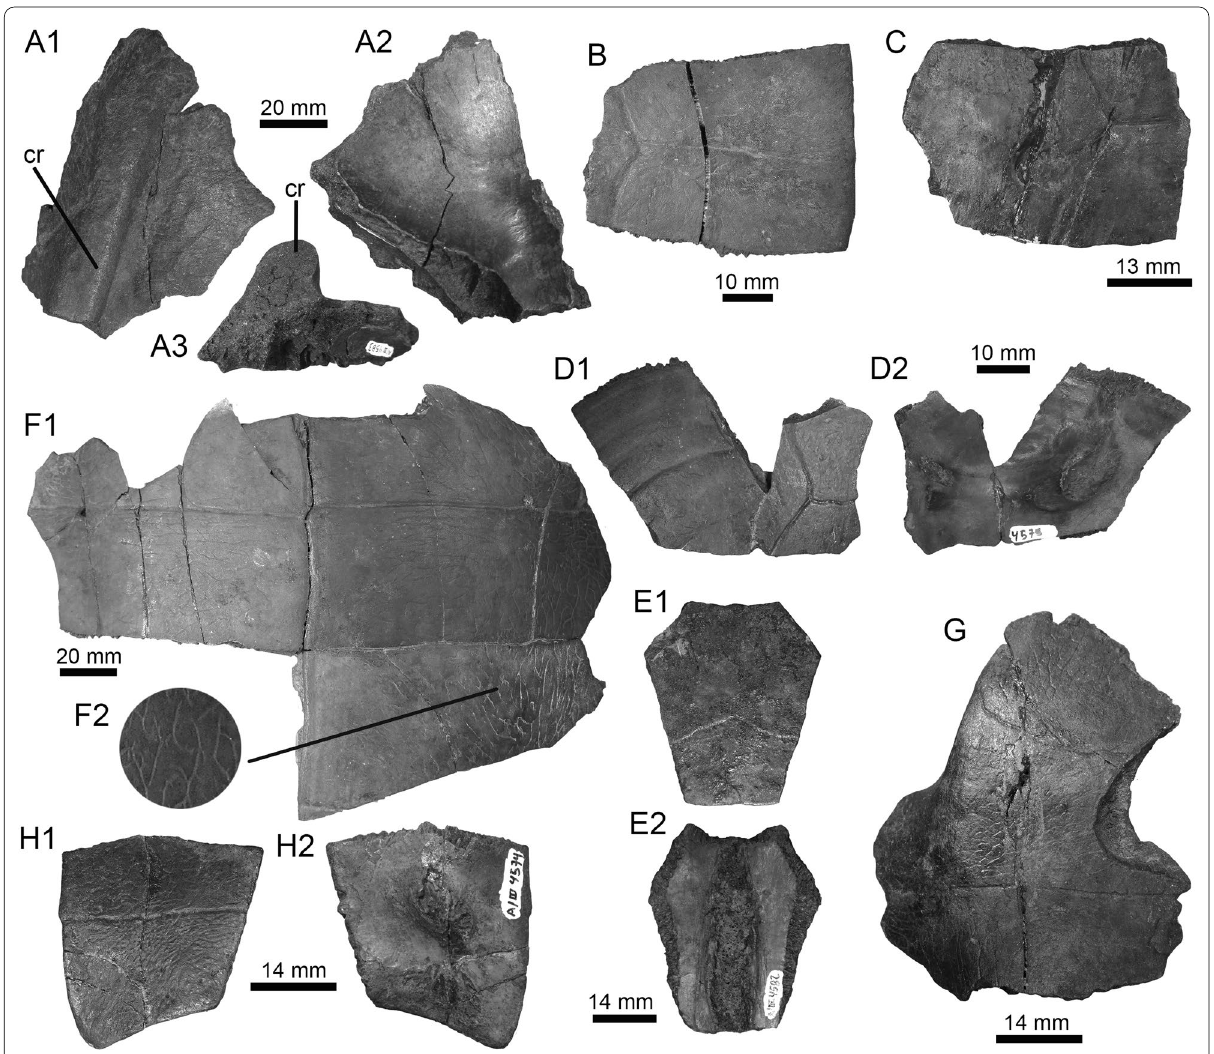
Fig. 8 Testudines from the Iquitos assemblage. A1 – A3 left costal 1 of † Chelus colombianus . B – H2 Indeterminate podocnemidids. B Peripheral bone (PIMUZ A/III 4574A). C – D2 Medial portion of a costal bone potentially costal 2 ( C : PIMUZ A/III 4576A) and left costal 1 ( D 1– D2 : PIMUZ A/III 4576B). E1 – E2 Neural bone, potentially neural 3 (PIMUZ A/III 4582). F 1– F2 Partially preserved plastron, including most of both hyoplastra and the left hypoplastron (PIMUZ A/III 4571), and close‑up ( F2 ) of its bone surface exhibiting dichotomy sulci. G Partially preserved right hyoplastron (PIMUZ A/III 4576C). H 1– H2 Complete right xiphiplastron (PIMUZ A/III 4574B). Abbreviations: cr (costal ridge). Views: external surface ( A1 , B – D1 , E1 , F1 – H1 ), internal surface ( A2 , D2 , E2 , H2 ), posterolateral ( A3